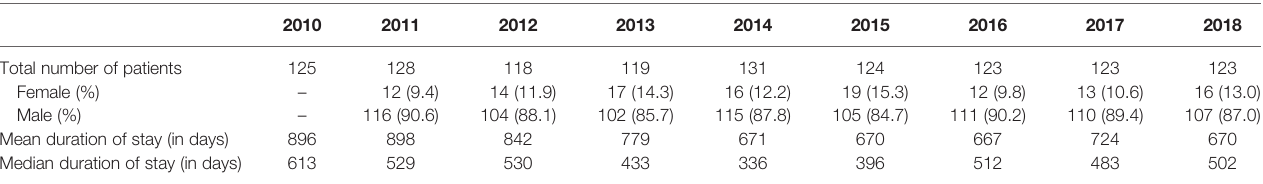
TABLE 1 | Total number of patients treated within the forensic